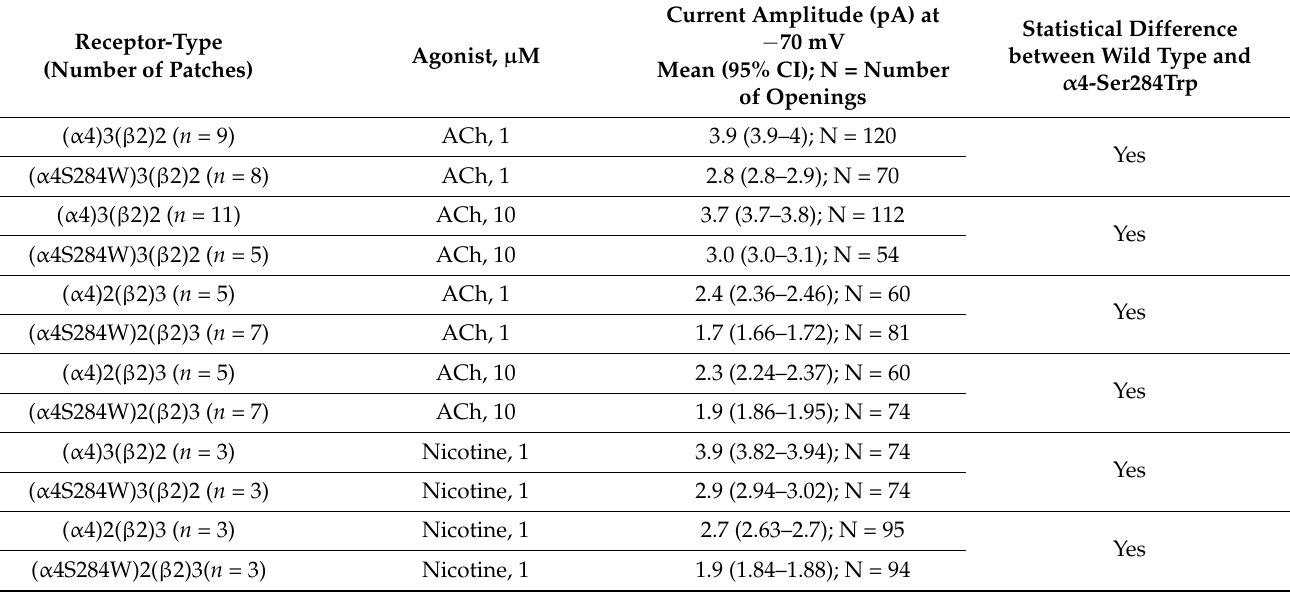
Table 2. Effect of α 4Ser284Trp on single channel current